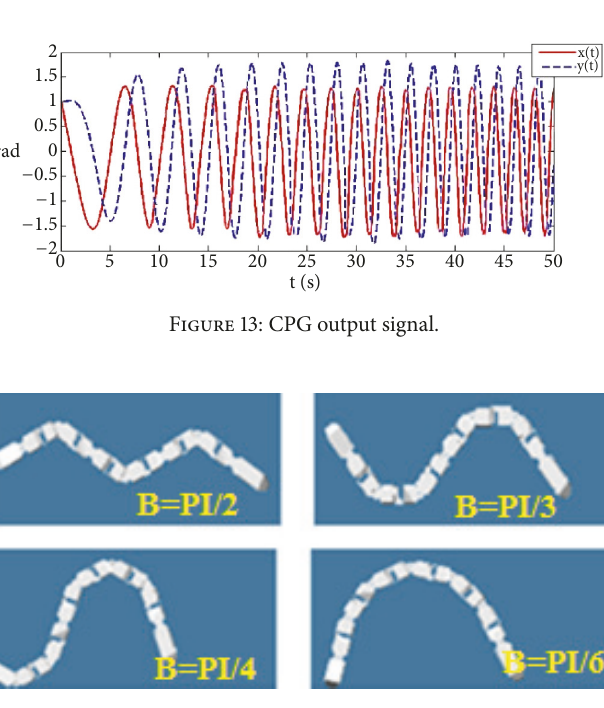
Figure 14: Exercise states at different B values.